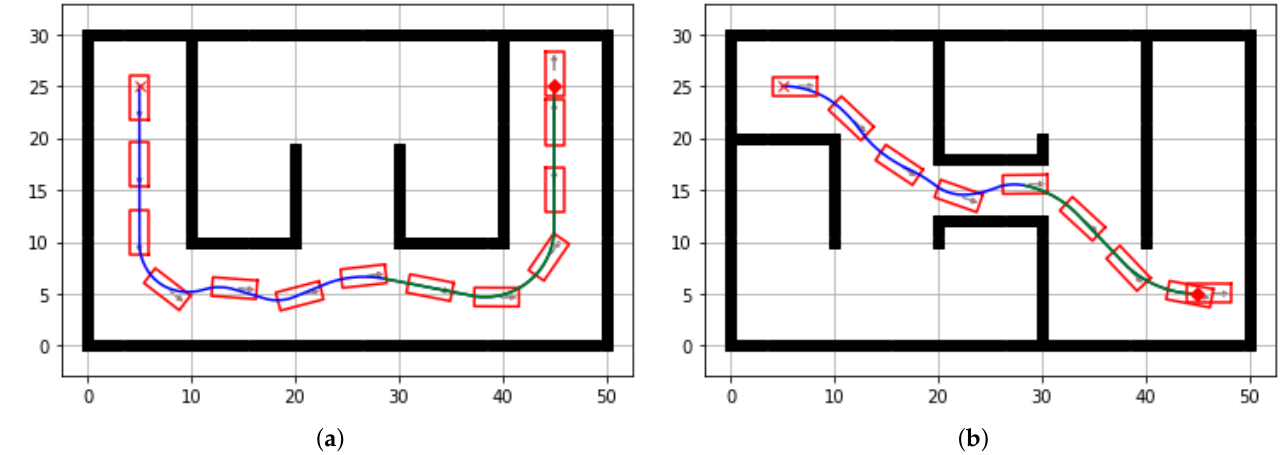
Figure 5. Improved Hybrid A-star path planning in indoor grid maps. ( a ) Grid map A. ( b ) Grid map